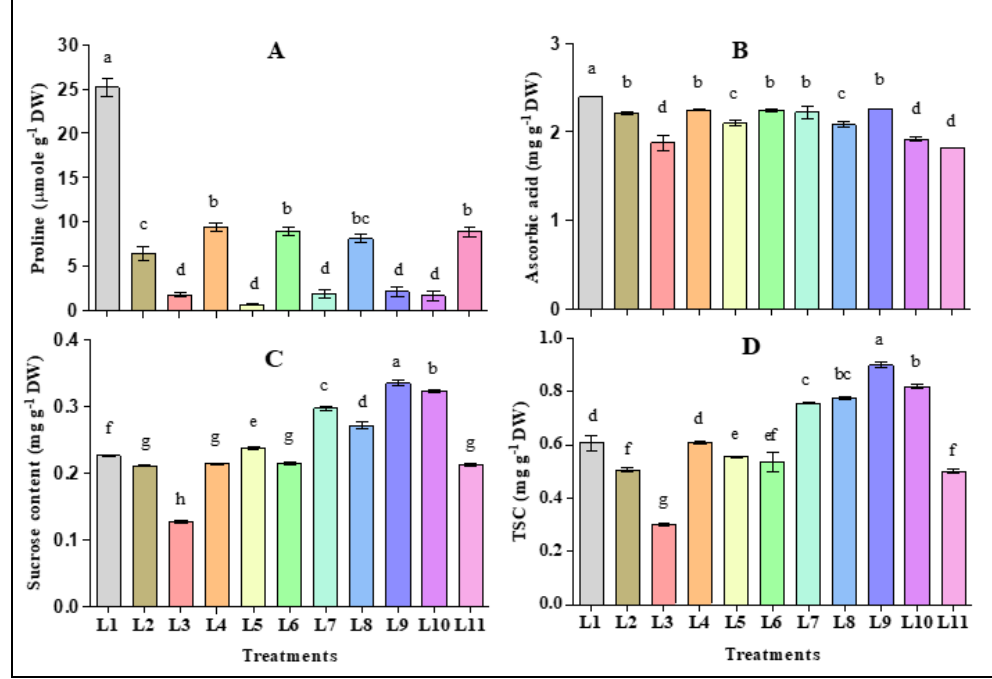
Figure 6. Effect of 20 days exposure to different LED spectra on proline ( A ), ascorbic acid ( B ), sucrose content ( C ), and total soluble carbohydrates (TSC; ( D )) of hemp seedlings. Here and subsequent figures: L1, Natural light; L2, White; L3, R 8 :B 2 ; L4, R 7 :B 2 :G 1 ; L5, R 7 :B 2 :FR 1 ; L6, R 6 :B 2 :G 1 :FR 1 ; L7, R 5 :B 2 :W 2 :FR 1 ; L8, R 5 :B 2 :G 1 :FR 1 :UV 1 ; L9, R 6 :B 2 :FR 1 :UV 1 ; L10, R 4 :B 2 :W 2 :FR 1 :UV 1 ; L11, R 2 :B 2 :G 2 :W 2 :FR 1 :UV 1 . All treatments used a photosynthetic photon flux density of 300 µ mol m − 2 s − 1 . Column height indicates the mean, vertical bars indicate the standard error of the mean (n = 4), and different letters indicate significant differences at p < 0.05.